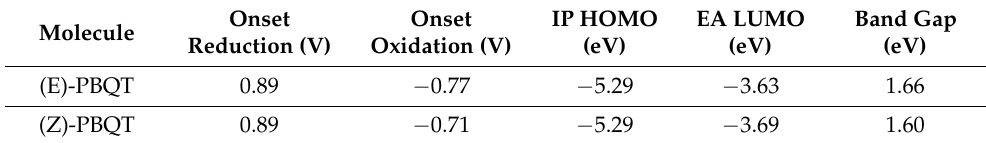
Table 4. Electrochemical properties of PBQT